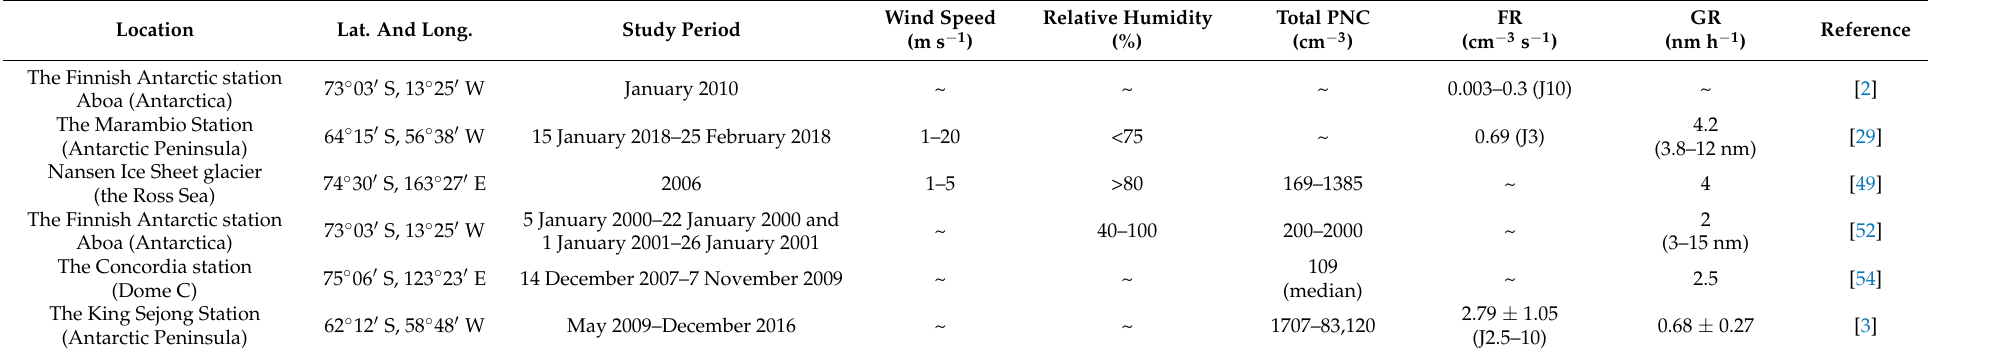
Table 2. Key parameters and related meteorological elements of NPF events occurred over the SO and